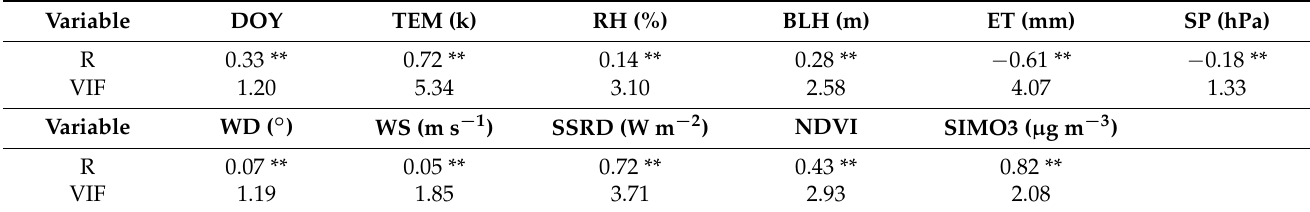
Table 2. Correlation and VIFs between the independent variables and O 3